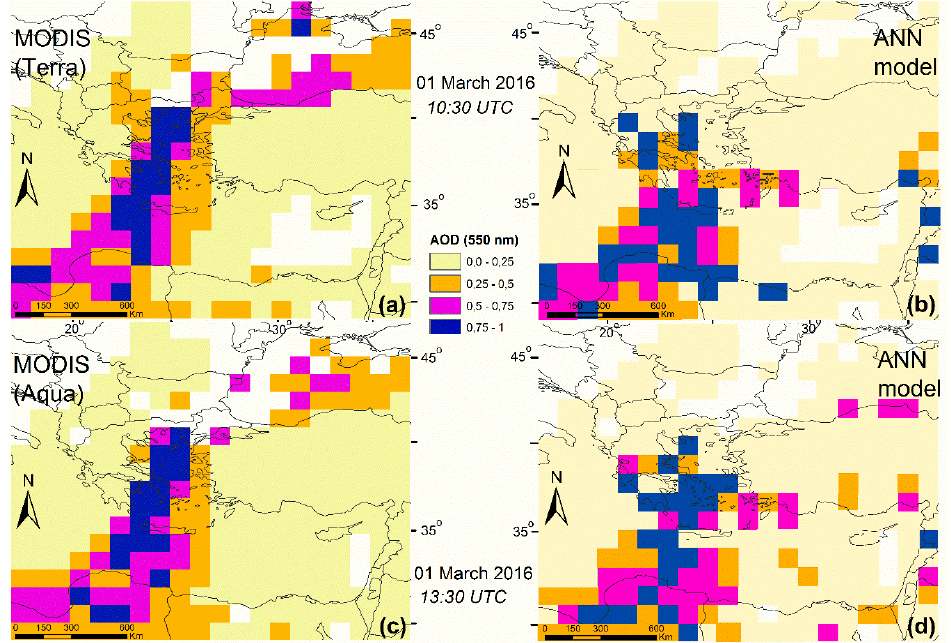
Figure 8. Comparison between MODIS-Terra and MODIS-Aqua daily AOD 550 nm data ( a , c ) and the corresponding AOD products of the ANN model ( b , d ) for the date on 1 March 2016.